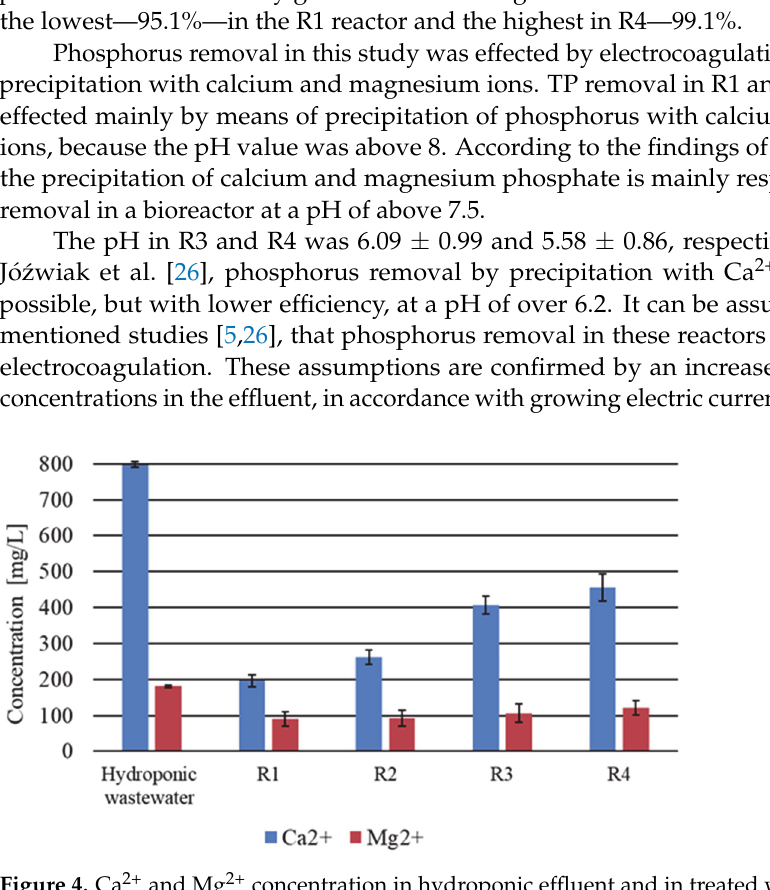
Figure 3. Efficiency of total nitrogen and total phosphorus removal from hydroponic effluent in a BER.